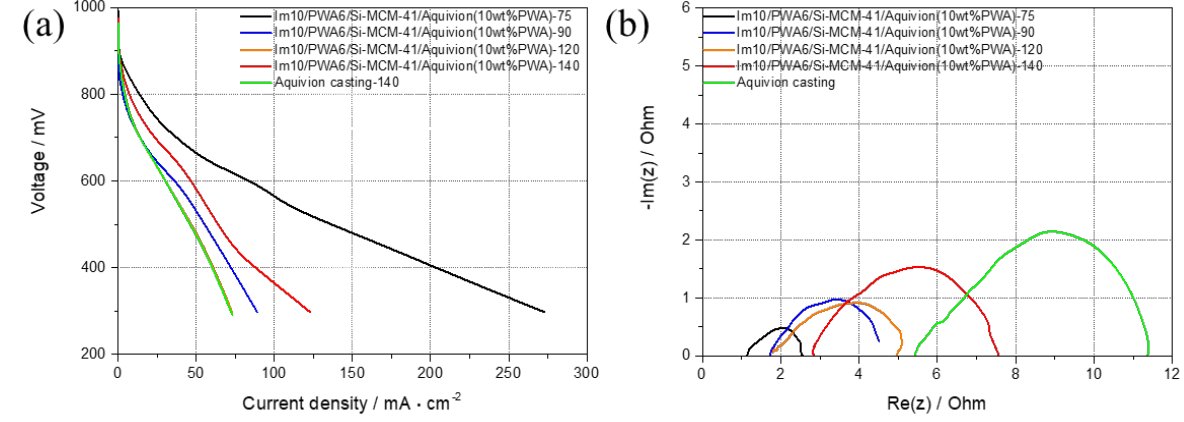
Figure 7. Single PEMFC performance of the Im10/PWA6/Si-MCM-41 composite membrane at 75 – 140 °C, 10% RH condition at H 2 /Air, plotted by ( a ) polarization curves and ( b ) impedance spectra with a reference of Aquivion TM casting membrane tested at 140 °C and same conditions.